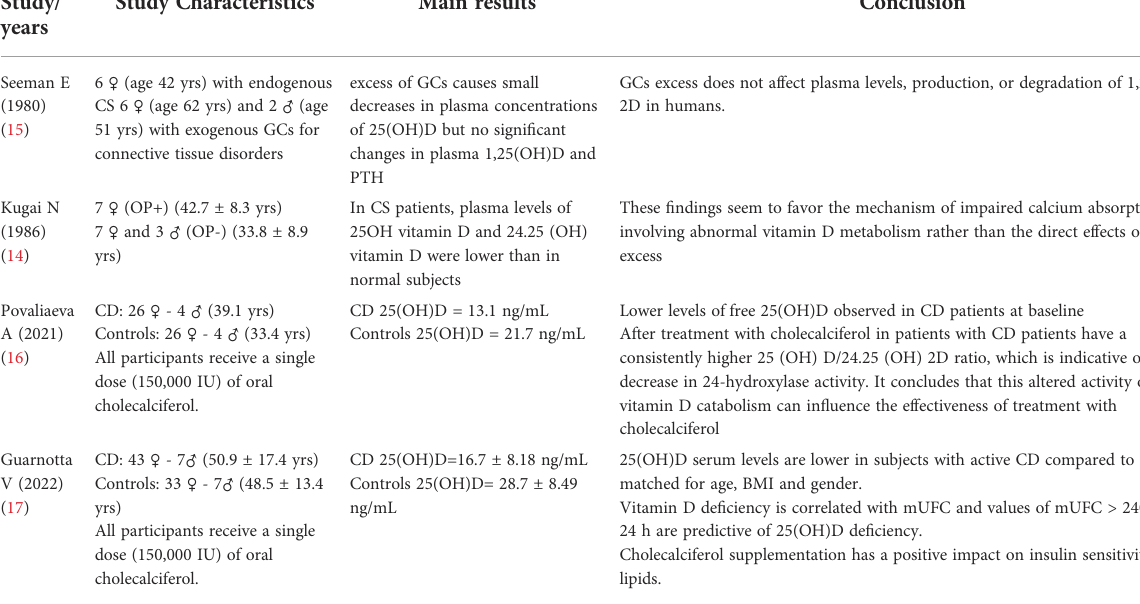
TABLE 1 Main characteristics of the 4 studies included in the review on Cushing Syndrome and Vitamin